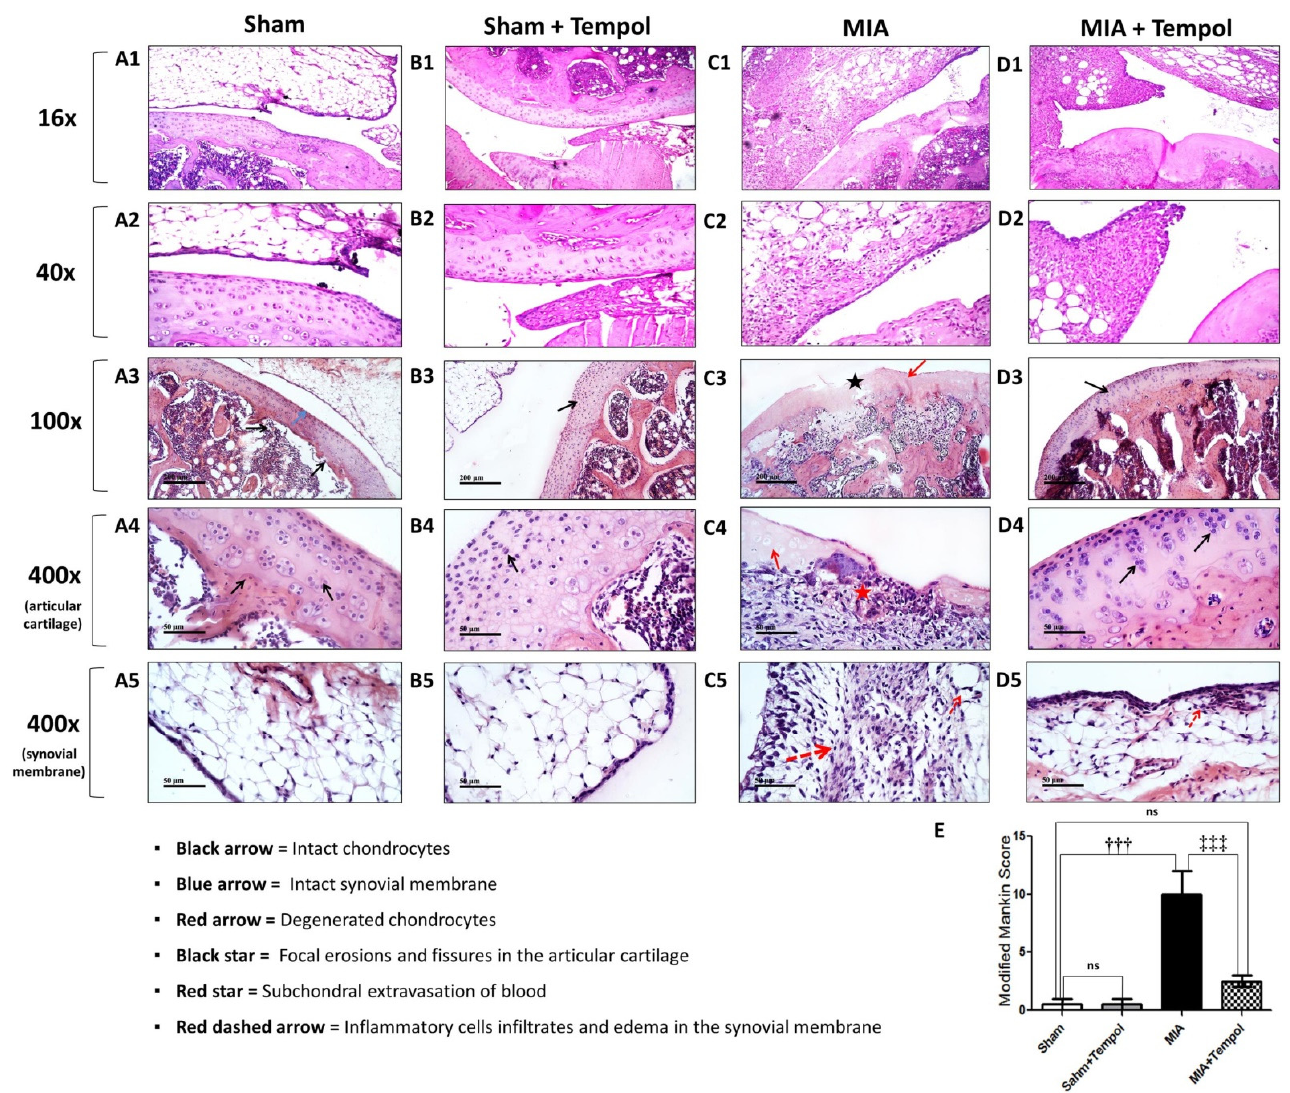
Figure 8. Effect of Tempol on representative H&E photomicrographs. The micrographs of the sham groups revealed normal histological structure of the chondroblasts in the outer surface and inner surface of the articular cartilage and the outer layer of epithelial cell and the inner collagen layer ( A1 , A2 , B1 , B2 ) with apparent intact isogenous chondrocytes (black arrow) and regular smooth articular surfaces ( A3 , B3 ). Intact synovial membranes and normal blood vessels are recorded as a blue arrow in the sections of ( A5 , B5 ). The worst distortion is observed in MIA-induced OA sections, where atrophy was detected in the chondroblasts of the outer surface of the articular cartilage and edema, inflammatory cells infiltration with fat in synovial membrane ( C1 , C2 ). severe degenerative and necrotic changes with significant loss of many chondrocytes (red arrow) are accompanied by many focal erosions and fissures of articular cartilage superficial zones (black star) in ( C3 ) photomicrograph with occasional subchondral extravasation of blood (red star) in ( C4 ). Significant edema of synovial membranes with many inflammatory cell infiltrates (red dashed arrow) recorded in ( C5 ). Photomicrographs of the tempol post-treated group ( D1 , D2 ) showed regeneration in the inner surface of the articular surface with absence of the chondroblasts at the outer surface and thickening in the wall of the synovial membrane. In addition, more intact chondrocytes (black arrows) and regular smooth articular surfaces ( D3 , D4 ). Mild inflammatory cell infiltrates (red dashed arrow) were also observed in synovial membranes ( D5 ). Panel ( E ) represents the means of the modified Mankin scoring system (Score range: 0–13, from normal cartilage to the maximal score of osteoarthritis), where the statistical analysis was carried out using one-way ANOVA followed by Tukey’s multiple comparison test. Results are expressed as mean ± SD ( n = 3). ††† p < 0.001 vs. the sham group, and ‡‡‡ p < 0.001 vs. MIA group.